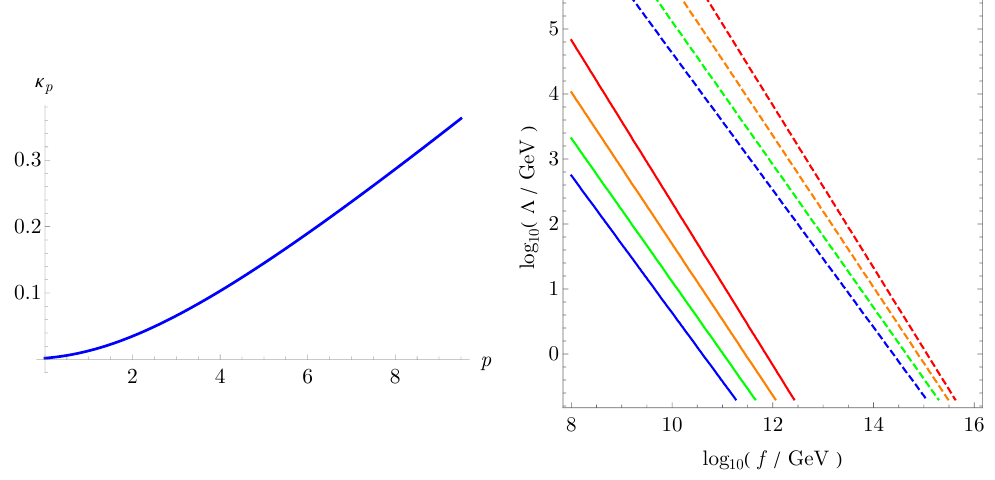
Figure 1 . Left: Value of the numerical factor (cid:20) p for the axion abundance (2.9), as a function of the power p of the temperature dependence. Right: Contours in the plane of the axion decay constant f and strong coupling scale (cid:3) that give rise to the observed dark matter abundance from a vacuum misalignment, for values of the power p = 2 (red), 4 (orange), 8 (green), 16 (blue), and misalignment angle (cid:18) ? = 1 (solid lines), 10 (cid:0) 2 (dashed lines). Other parameters are (cid:12)xed to (cid:21) = 0 : 1, (cid:24) = 0 : 1, g (cid:3) ( T osc ) = g s (cid:3) ( T osc ) = 100. The lower edge of the plot represents (cid:3) =